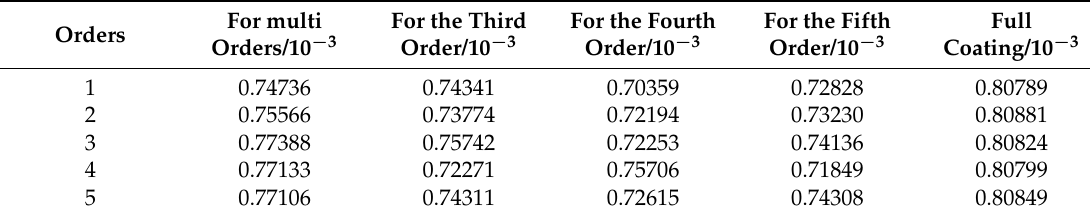
Figure 11. The damping optimization scheme simultaneously for the third, fourth, and fifth order. Table 7. Comparison among the damping optimization results for a certain order, for multi orders, and the results corresponding to the full coating structure.